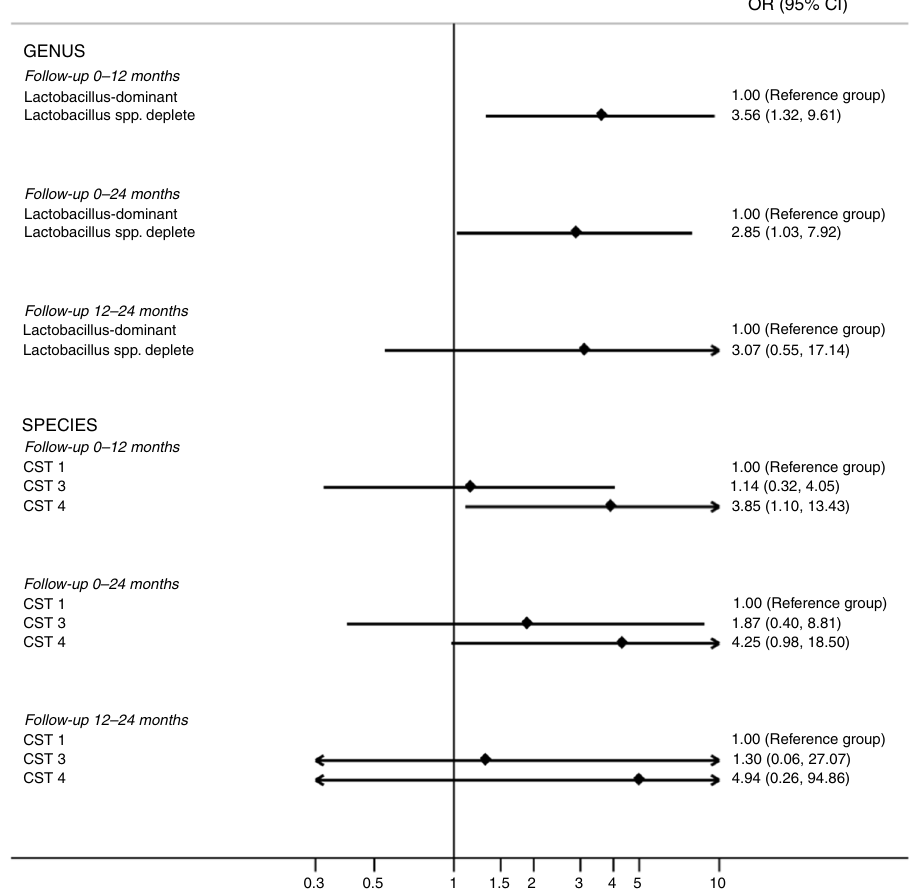
Fig. 3 Odds ratios and 95% con fi dence intervals of the association between the vaginal microbiome at genera and species level with risk of CIN2 non- regression (vs regression) at different follow-up timepoints (baseline to 0 – 12 month; baseline to 0 – 24 month; 12 to 12 – 24 month). Odds ratios have been adjusted for age, ethnicity, contraception, douching, smoking and HPV16 and 18 status. CI con fi dence interval, CST Community state type, CST I Lactobacillus crispatus -dominant, CST III Lactobacillus iners -dominant, CST IV Lactobacillus spp.-depleted, high diversity, OR odds